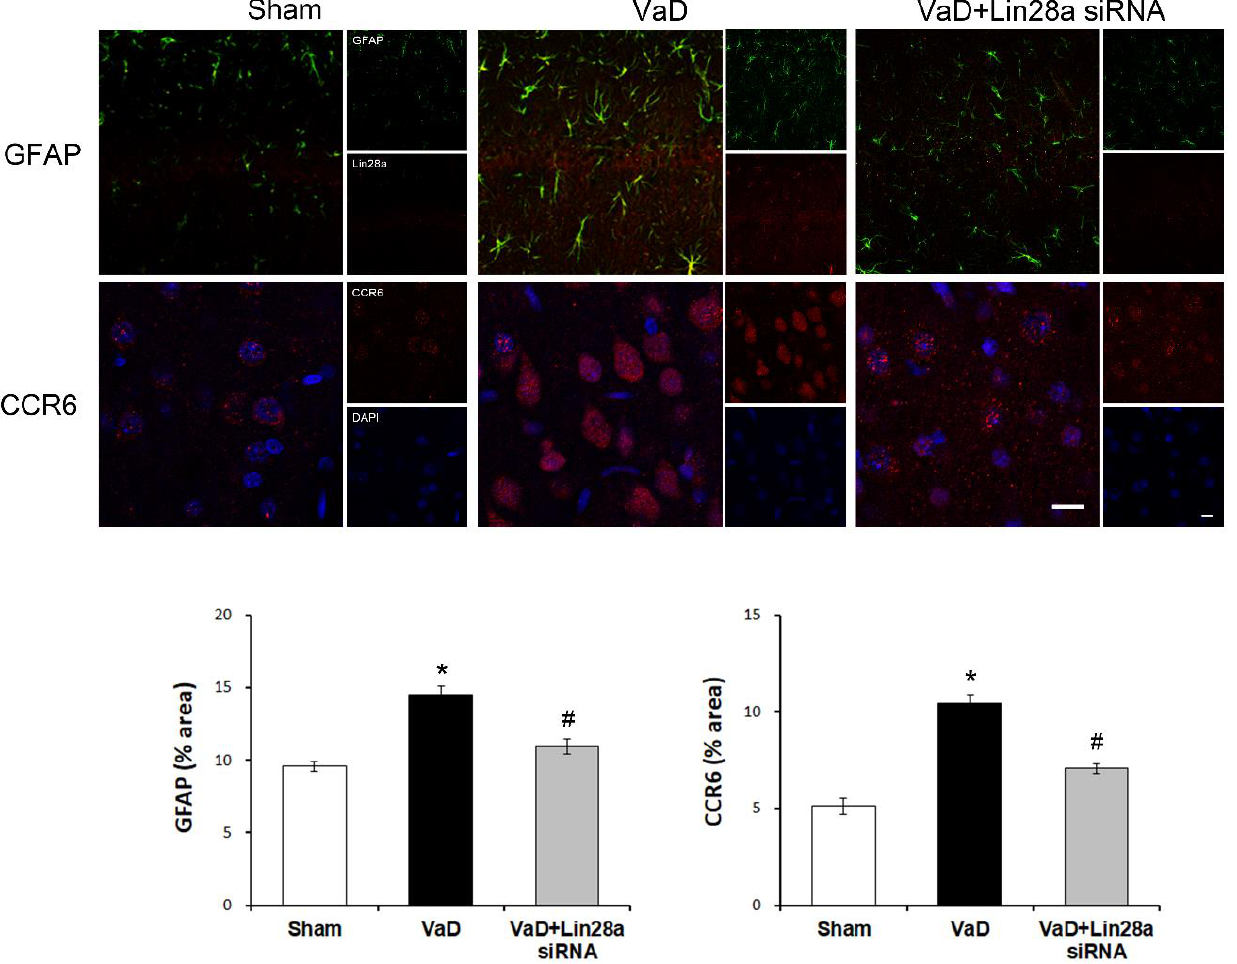
Figure 4. Blocking Lin28a inhibits the activation of GFAP and CCR6 in the brain after VaD. Representative photographs of immunofluorescent staining of GFAP (green), Lin28a (red), CCR6 (red), and DAPI (blue) in the brain. The data are presented as the mean ± S.E.M. * p < 0.05, compared to the sham group. # p < 0.05, compared to the VaD group. A scale bar represents 20 μm .